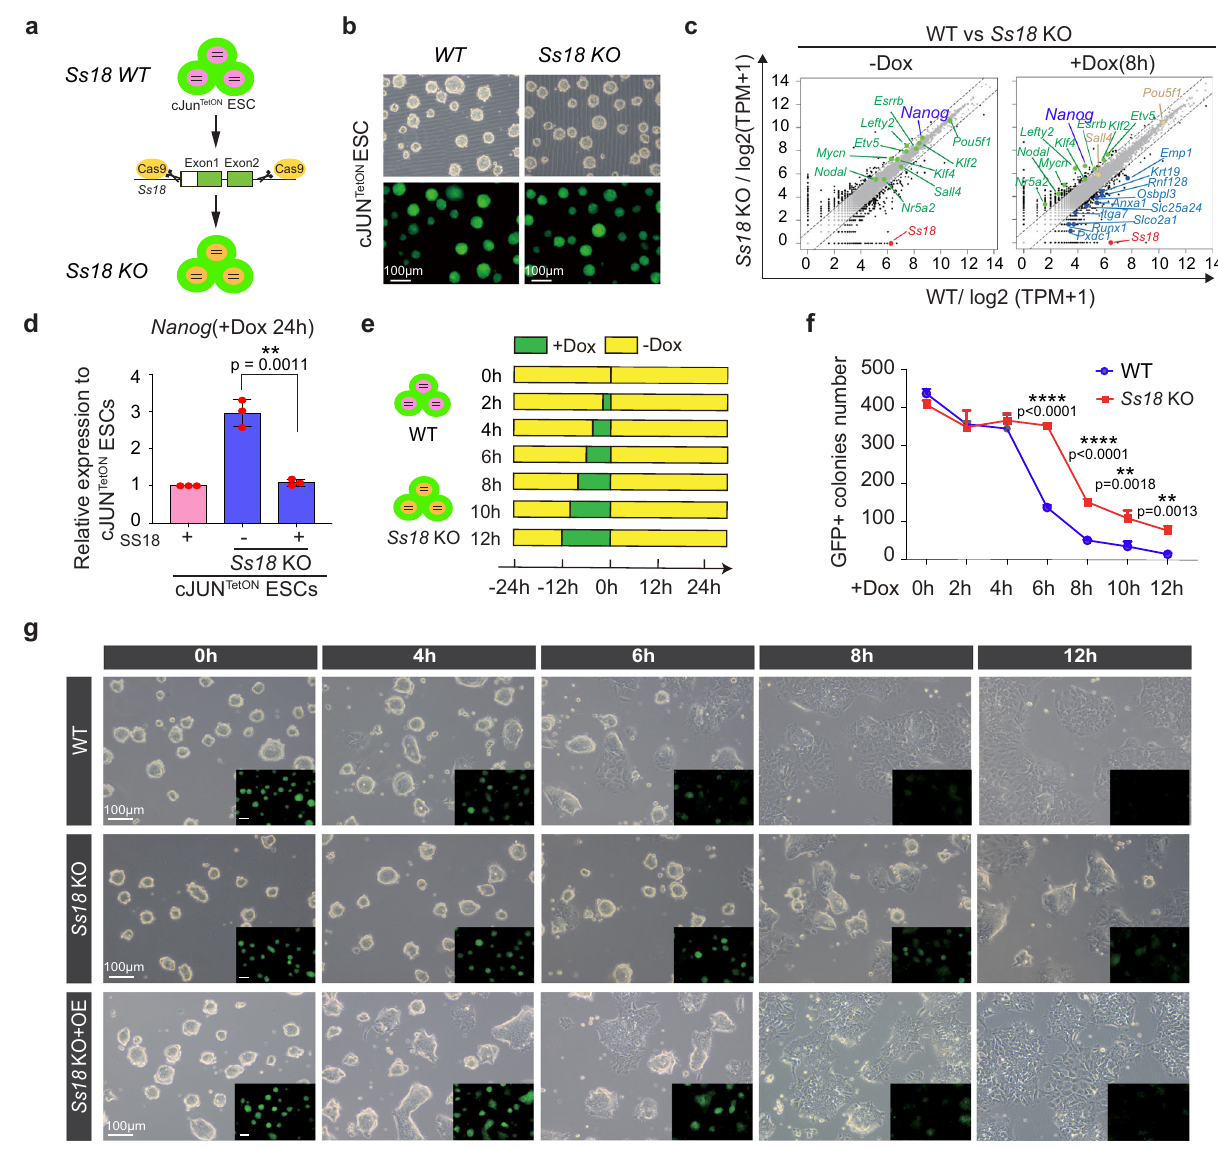
Fig. 2 SS18 Regulates cJUN-induced PST. a Construct design for SS18 knockout in mESC. The cleavage sites of Cas9 were designed fl anking exon1 and exon2 within Ss18 loci. b SS18KO mESCs are similar to WT ones in morphology. Three biological replicates. c Gene expression pro fi les by RNA-seq for WT and SS18 KO mESCs. SS18 knockout has little impact on most pluripotent genes but delays the c-JUN induced PST process signi fi cantly. d Rescue of the delayed PST as indicated by Nanog expression in SS18 KO mESCs with SS18 in lentiviral vector. Data are mean ± s.d., two-sided, unpaired t test; n = 3 independent experiments, ** p < 0.01. e The experimental design to test the window of sensitivity for SS18 response to c-Jun-induced PST. f Results from ( e ) to show that OCT4-GFP positive colony numbers recovered for 48 h in 2i/LIF medium after c-Jun induction at the indicated time points for wild type and SS18 KO ESCs. Data are mean ± s.d., two-sided, unpaired t test; n = 3 independent experiments. ** p < 0.01, **** p < 0.0001. Note no change for 4 h and the greatest change at 6 h for the window of sensitivity. g Representative images for the c-Jun-induced PST in WT, Ss18 − / − and Ss18 − / − overexpressing Ss18 , respectively. Three biological